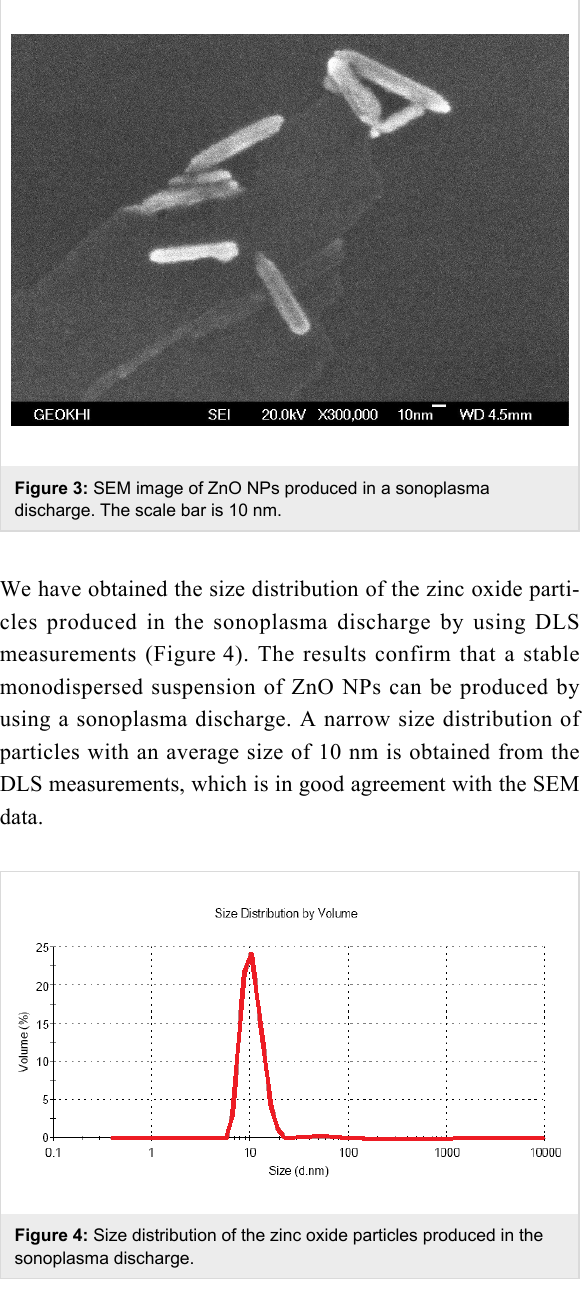
It was relevant for the coating process that the suspension produced in the sonoplasma discharge was used for coating immediately after production. Otherwise the nanoparti- cles formed agglomerates with the average size of 1–5 μ m. This fact was confirmed by using SEM imaging. Figure 5 shows a SEM image of the agglomerates that appeared in the suspen- sion after 1 h.